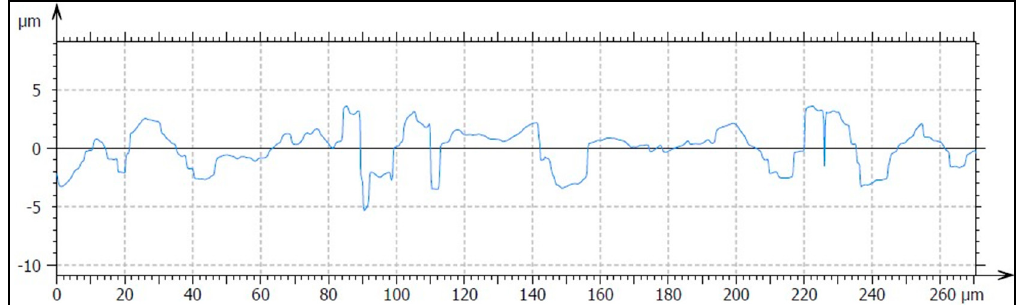
Figure 13. HA/TCP surface profilometry.